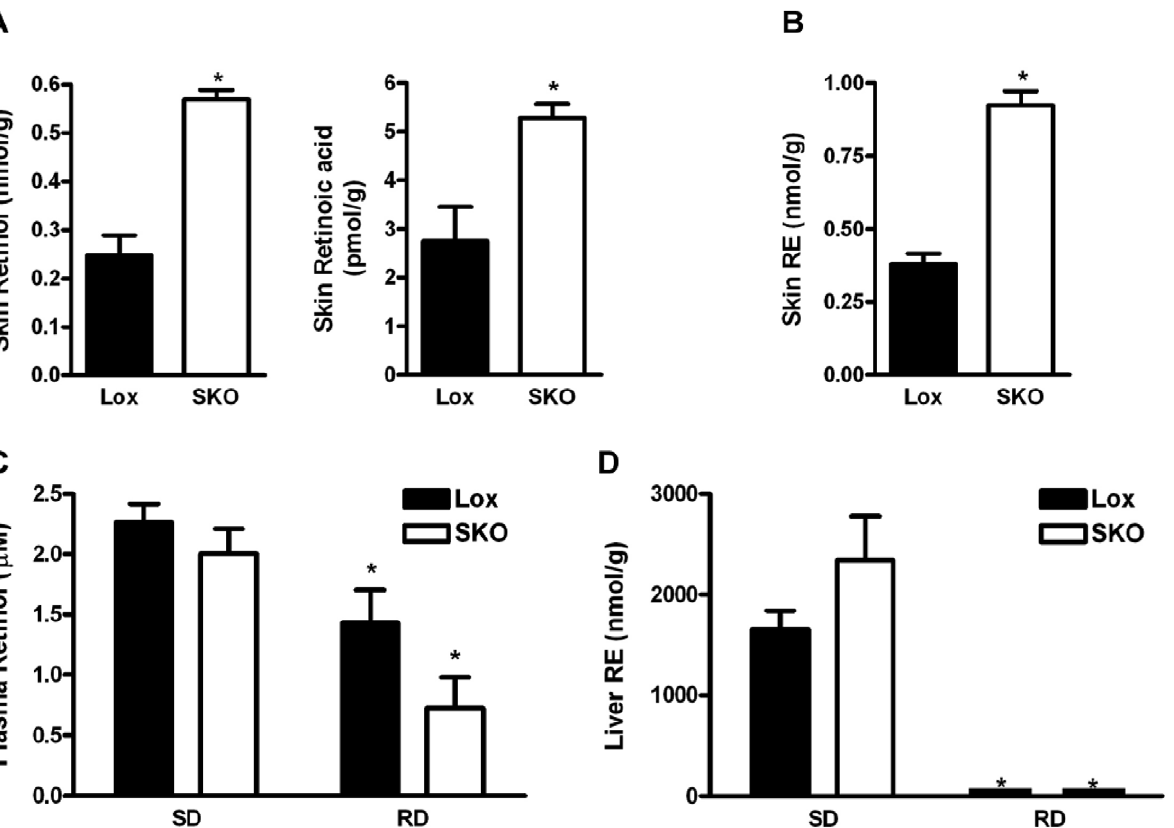
Figure 2. Altered retinoid homeostasis in SKO mice. A) Skin retinol and retinoic acid, as well as B) skin retinyl esters (RE) in male mice fed the standard diet (SD). *= p , 0.05 for lox vs. SKO, n=7–8 per group. C) Plasma retinol levels and D) liver RE levels in male mice fed either SD (n=7–8 per group) or a retinoid-deficient (RD) diet (n=6 per group). Data represent mean 6 SEM. # = p , 0.05 for SD vs. RD within same genotype.